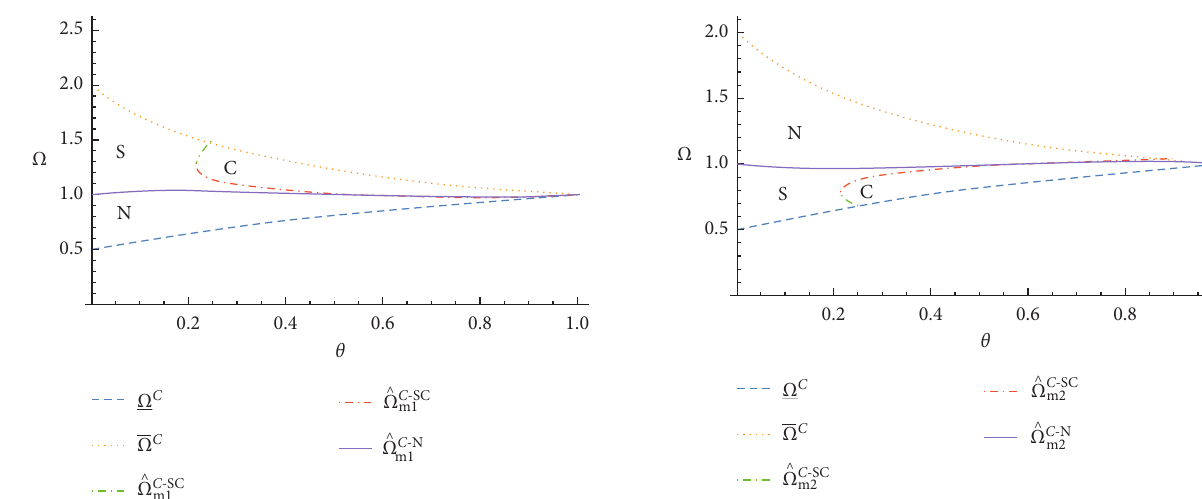
Figure 1: Cooperation mode choice for manufacturer 1.